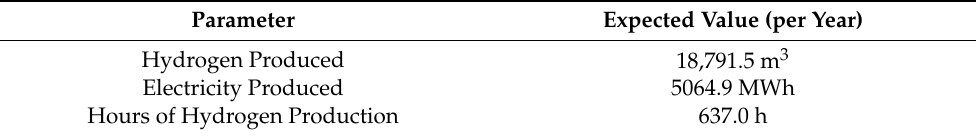
Table 5. Dispatch values for the system at a levelized cost of hydrogen of 98.1 JPY/m 3 .